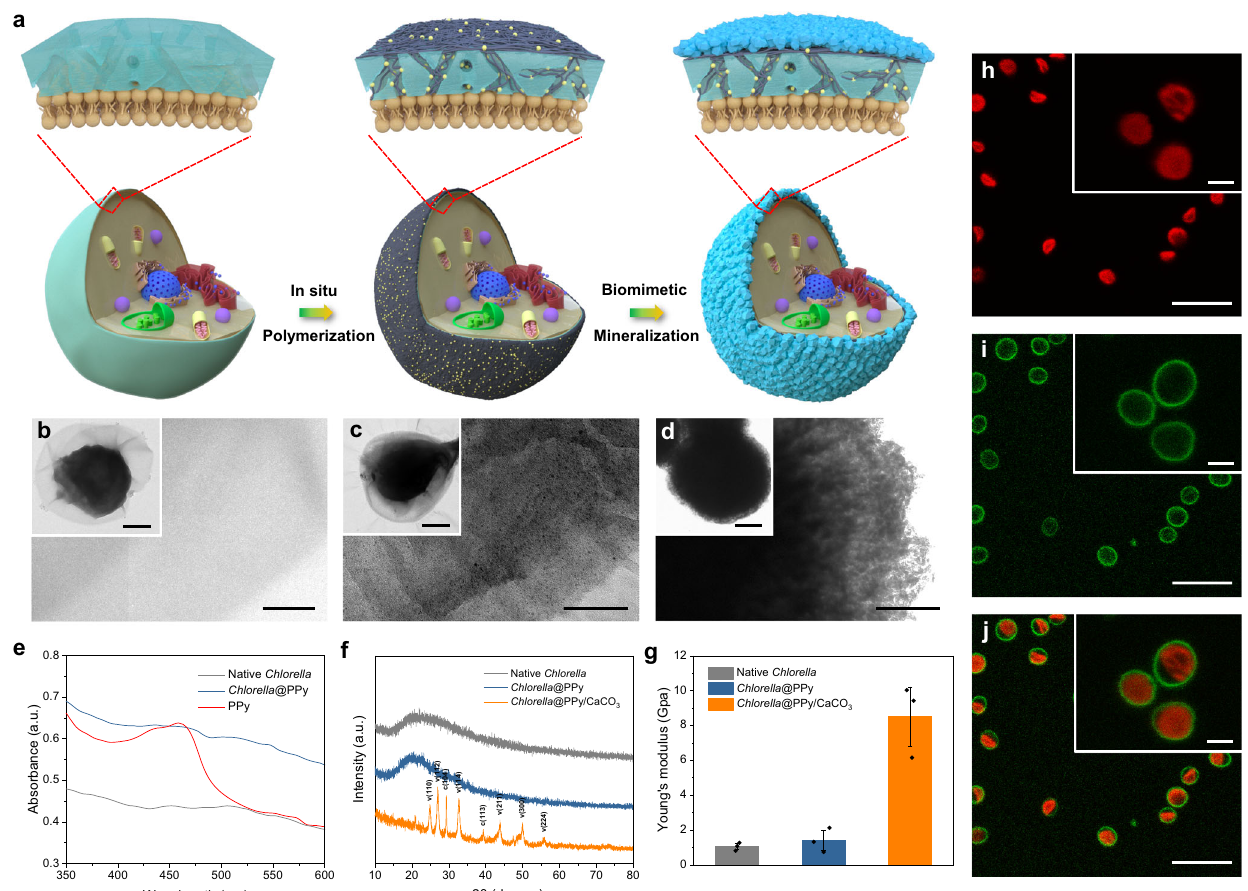
Fig. 1 | Micro-niche construction by polymer/inorganic coating of live algal cells. a Schematic illustration showing the stepwise construction of concentrically arrangedPPyandCaCO 3 thinshellsonthecellwallofthealga Chlorellapyrenoidosa (small yellow spheres, Fe(III) ions; black inner shell, PPy; light blue outer shell, CaCO 3 ). b – d TEM images oflocalized regions and whole cells (insets)ofnative ( b ), PPy-coated ( c ) and PPy/CaCO 3 -coated Chlorella cells ( d ) showing increased elec- tron density and granularity associated with the coatings. e UV – Vis spectra of PPy, nativeandPPy-coated Chlorella cells. f XRDpatternsofnative,PPy-coatedandPPy/ CaCO 3 -coated algal cells; Miller indices for calcite ( c ) and vaterite ( v ) are shown.